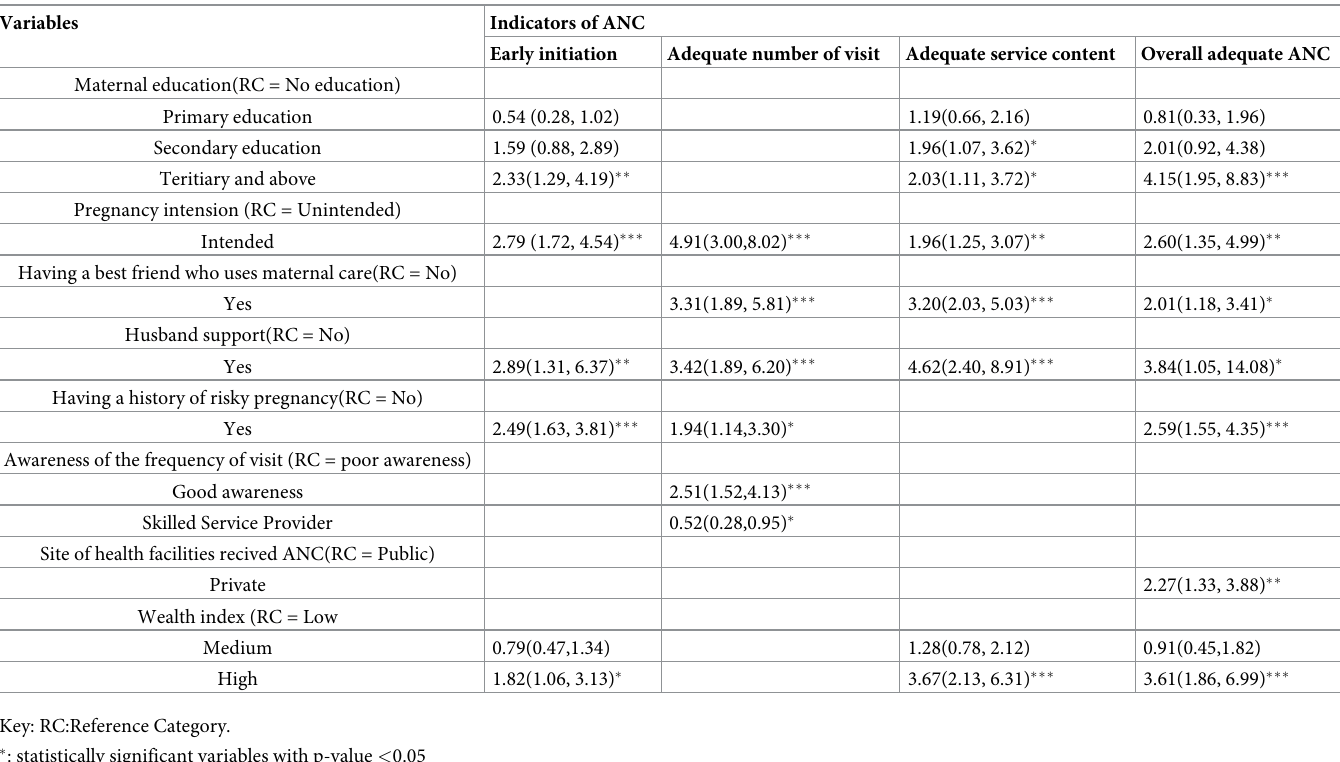
Table 5. Results of adequate ANC service utilization to identify determinants of adequate ANC service utilization in Southern Ethiopia,